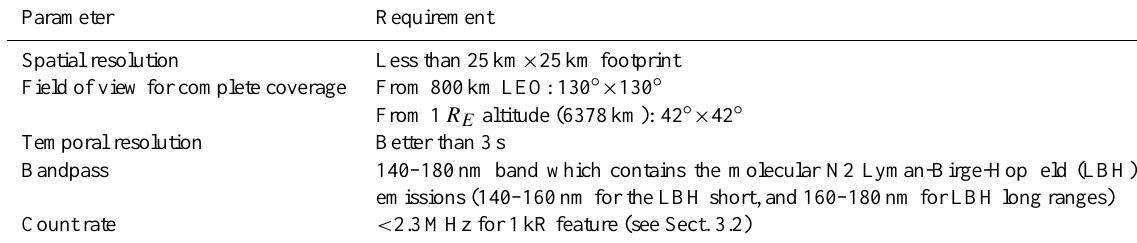
Table 1. Performance requirements of a wide field FUV auroral imager in polar